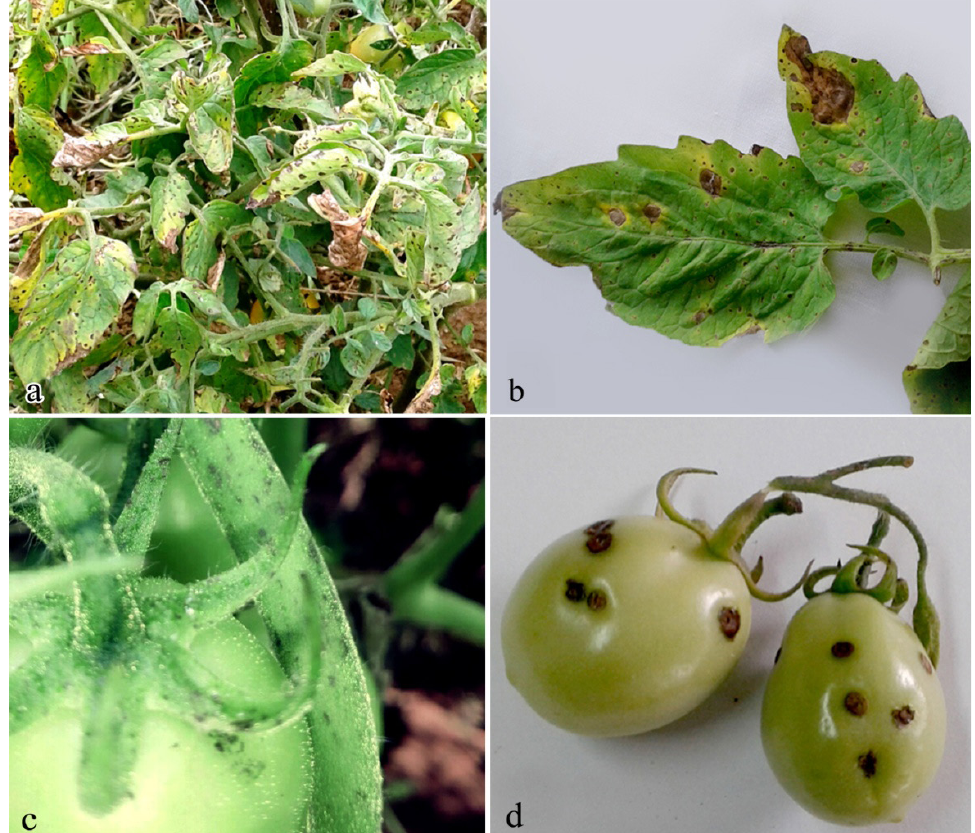
Figure 1: (a) Severely infected tomato plants showing target spot symptoms, (b) in leaves, (c) stem, and (d) fruits at farmers’ field in